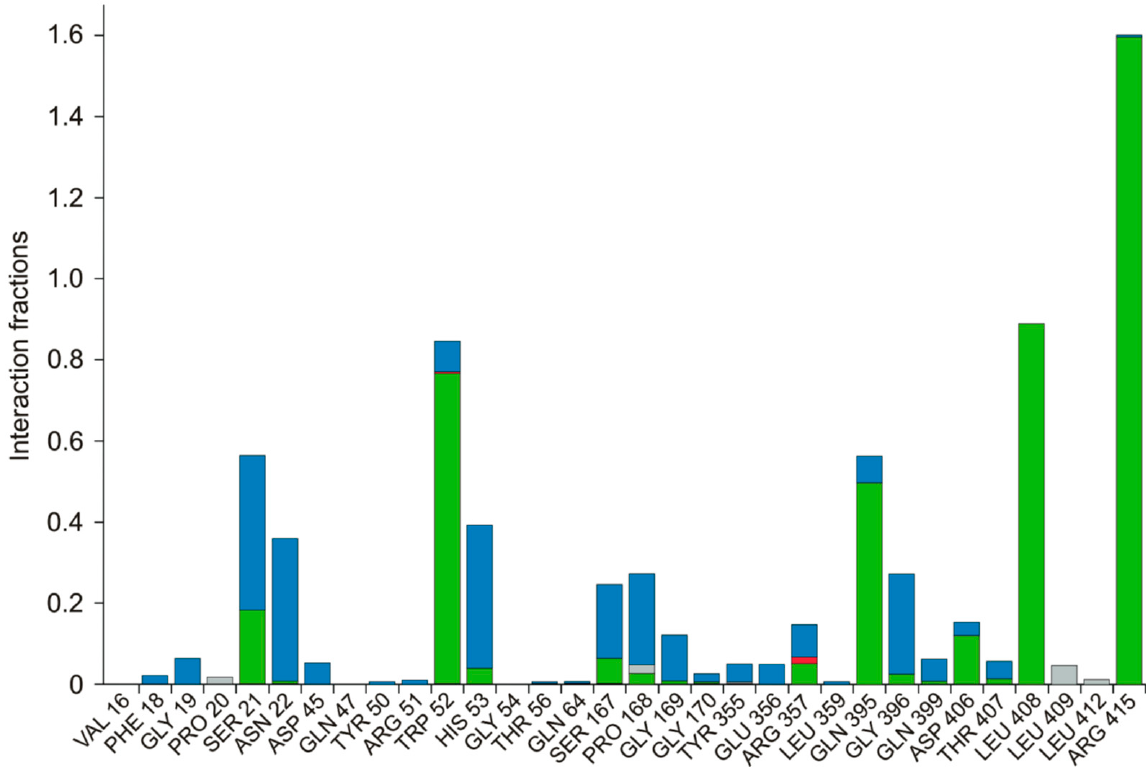
Figure 5. Various interactions of the ligand with the amino acids are represented. Amino acids of PvdA that have interactions with the ligand and the type of interaction are provided. Green— Hydrogen Bond; Red—Ionic; Lavender—Hydrophobic; Blue—Water Bridge. Arg357 was found to have three kinds of interactions, namely, a hydrogen bond, water-bridge, and ionic interaction. The interaction fraction is the number of interactions had by a residue normalized by the simulation time during which the interaction existed. An interaction fraction that is more than 1 is possible when the particular residue has more than one